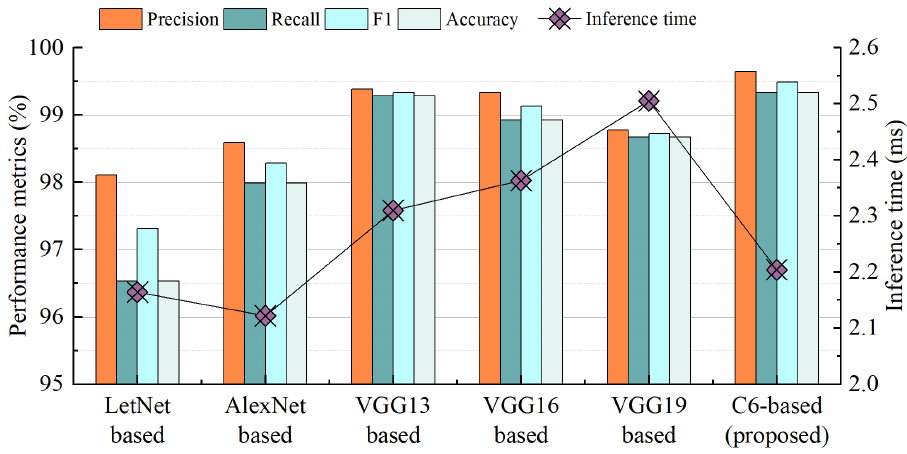
Figure 12. Effect of different CNN-based models on recognition performance.